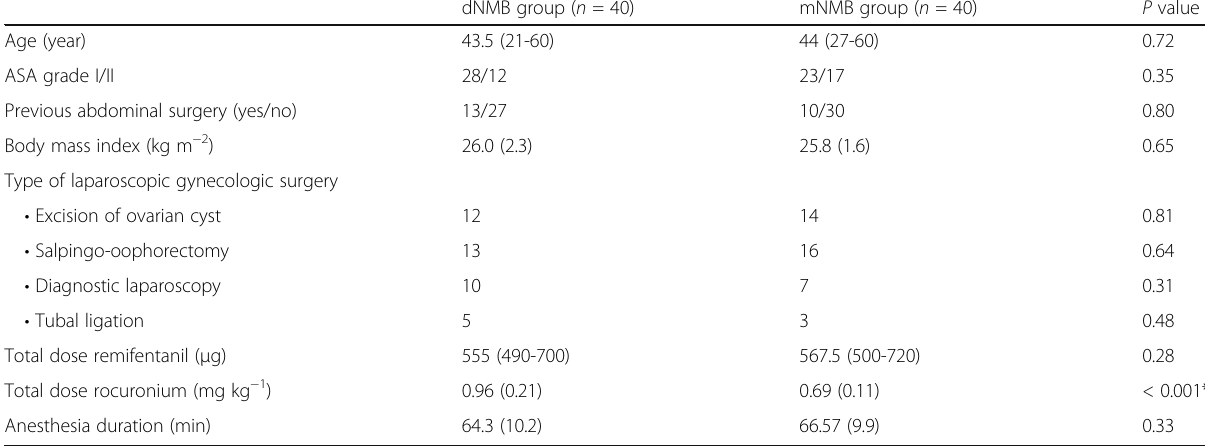
Table 2 The demographic and anesthetic data between the groups. Values are mean (SD), median (range), or numbers dNMB group ( n = 40)